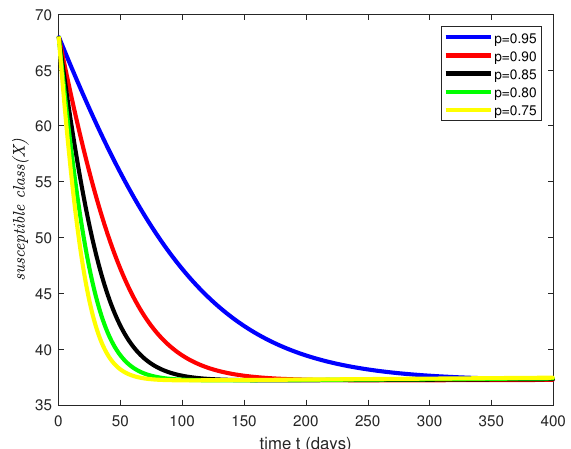
Figure 1. Adaptive nature of the approximated result for the susceptible class X ( t ) class of the considered model at different arbitrary fractional